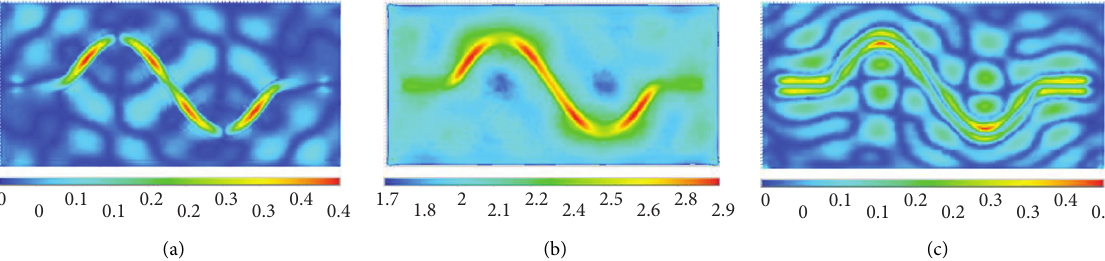
Figure 50: SH wave incident ( f � 2.0Hz, H � 100m, and C